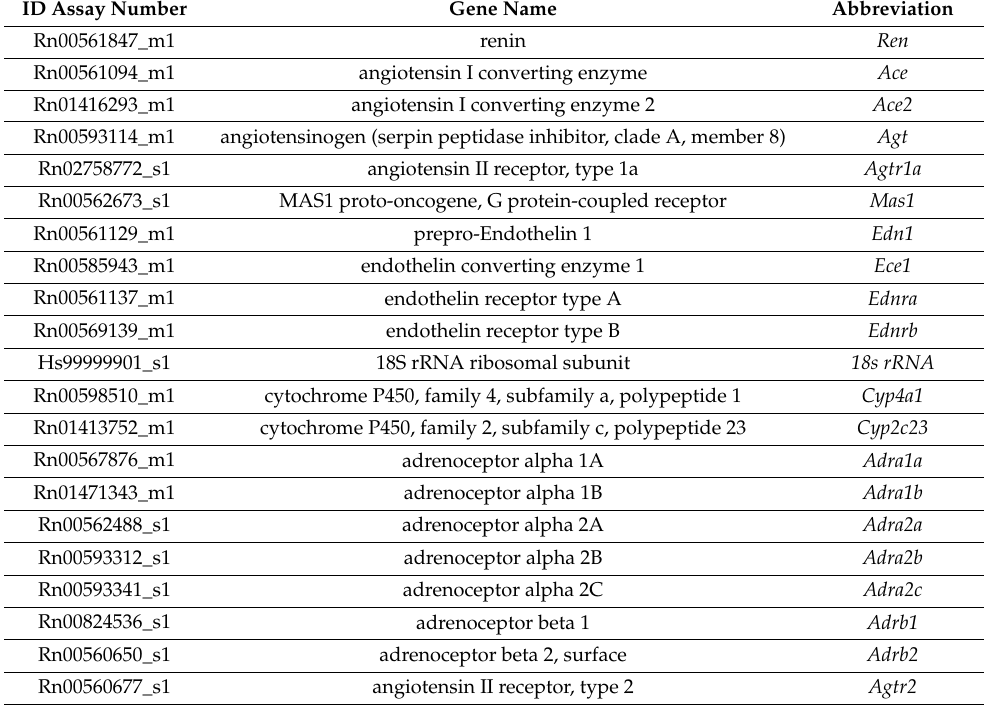
Table 2. The genes analyzed in the kidney